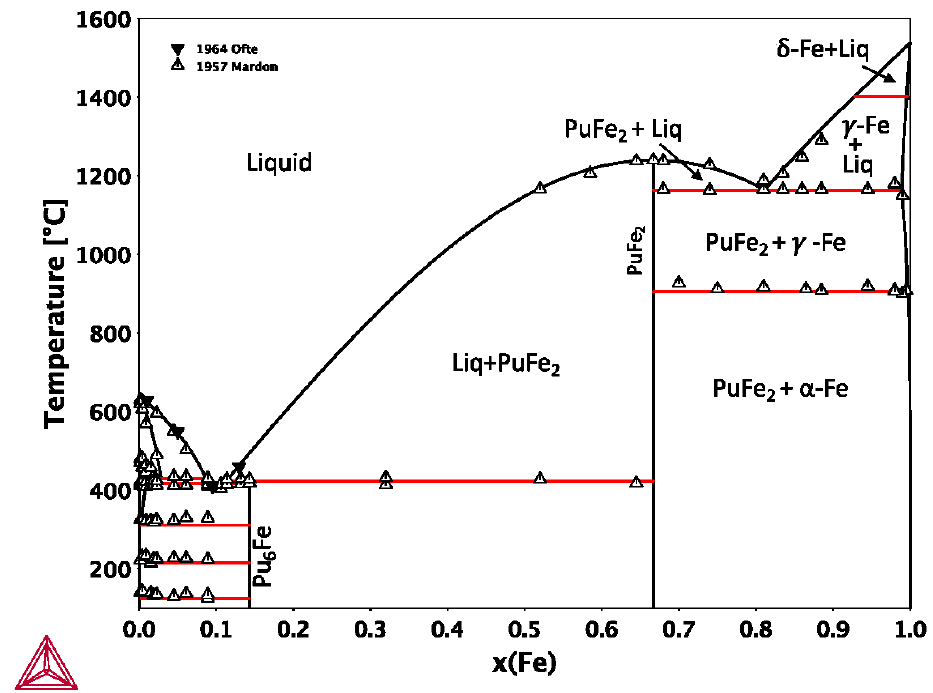
Figure 1. Calculated Pu-Fe phase diagram based on the present CALPHAD assessment and compared with experimental data [45,46].